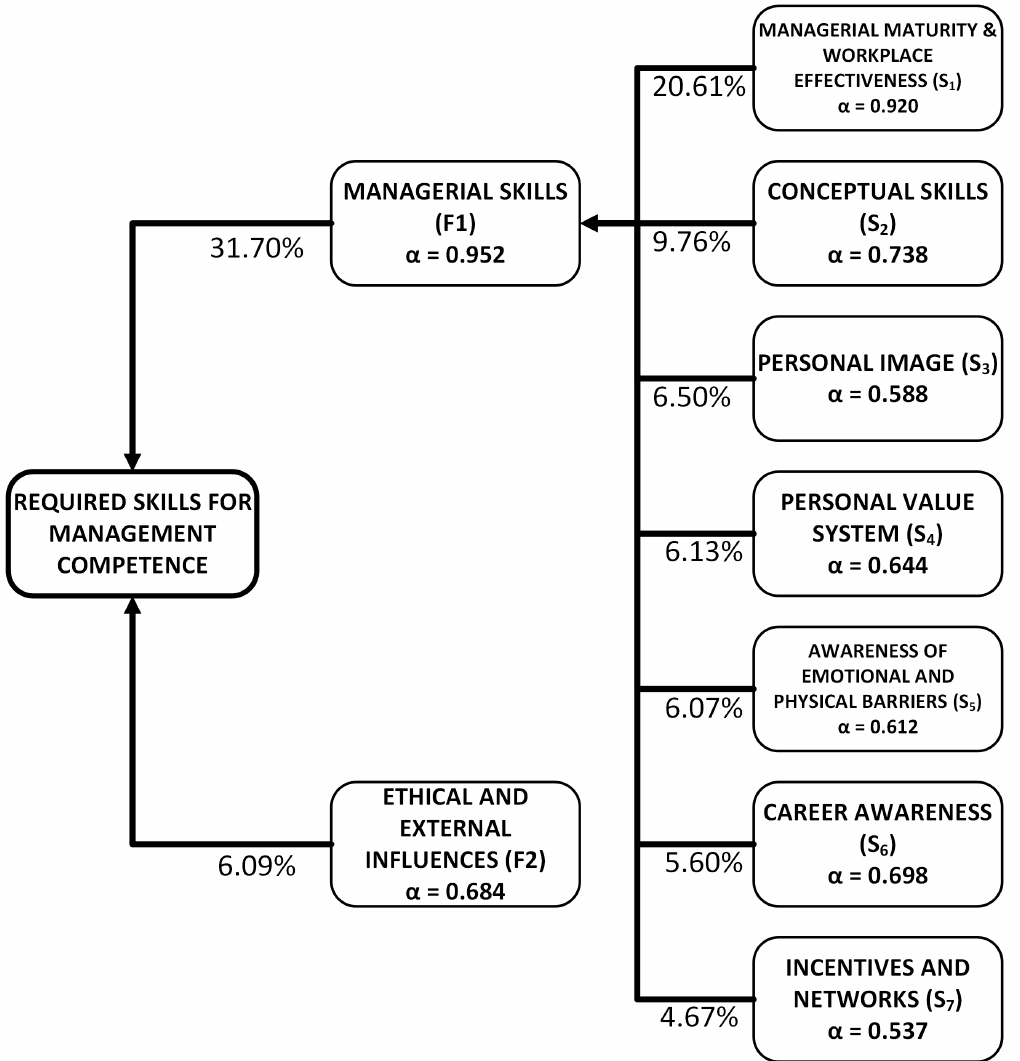
Figure 3. A model to measure skills for managerial competence at